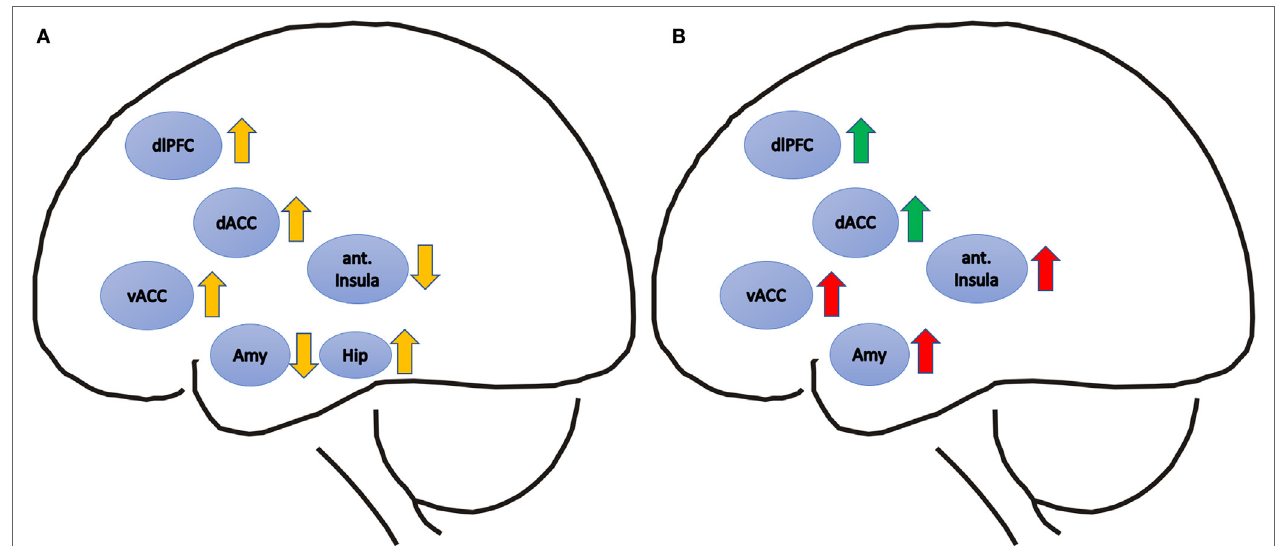
FigUre 1 | (a) Pre-to-post-treatment signal differences in post-traumatic stress disorder patients are depicted with yellow arrows. Upward arrows represent relatively increased, downward arrows relatively decreased activation after treatment. (b) Positive correlations of pre-treatment functional magnetic resonance imaging (fMRI) activity and symptom improvement are depicted with green arrows, and positive correlations of pre-treatment fMRI activity and symptom persistence are depicted with red arrows. Brain regions: dACC, dorsal anterior cingulate cortex; vACC, ventral anterior cingulate cortex; ant. Insula, anterior Insula; dlPFC, dorsolateral prefrontal cortex; Amy, amygdale; Hip,